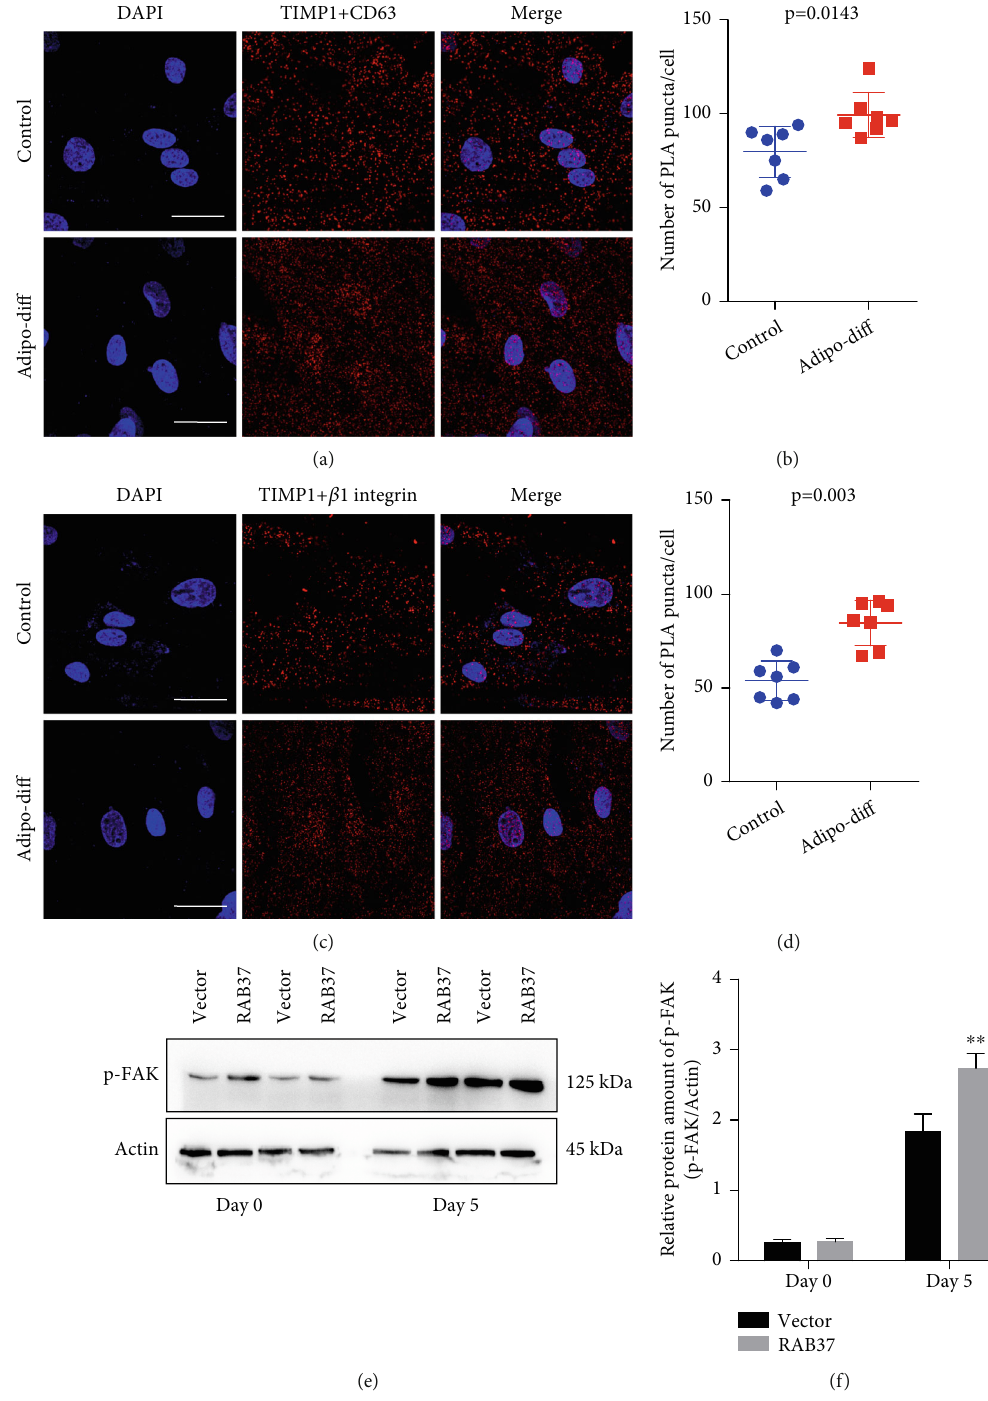
Figure 5: TIMP1 activated integrin β 1 signaling in RAB37-mediated adipogenic di ff erentiation. (a) hADSCs were subjected to induction of adipogenic di ff erentiation for 5 days. PLA was performed to determine the interaction between TIMP1 and CD63. (b) Quantitative analysis of PLA assay of TIMP1 and CD63, n = 8 . (c) PLA was performed to determine the interaction between TIMP1 and integrin β 1.